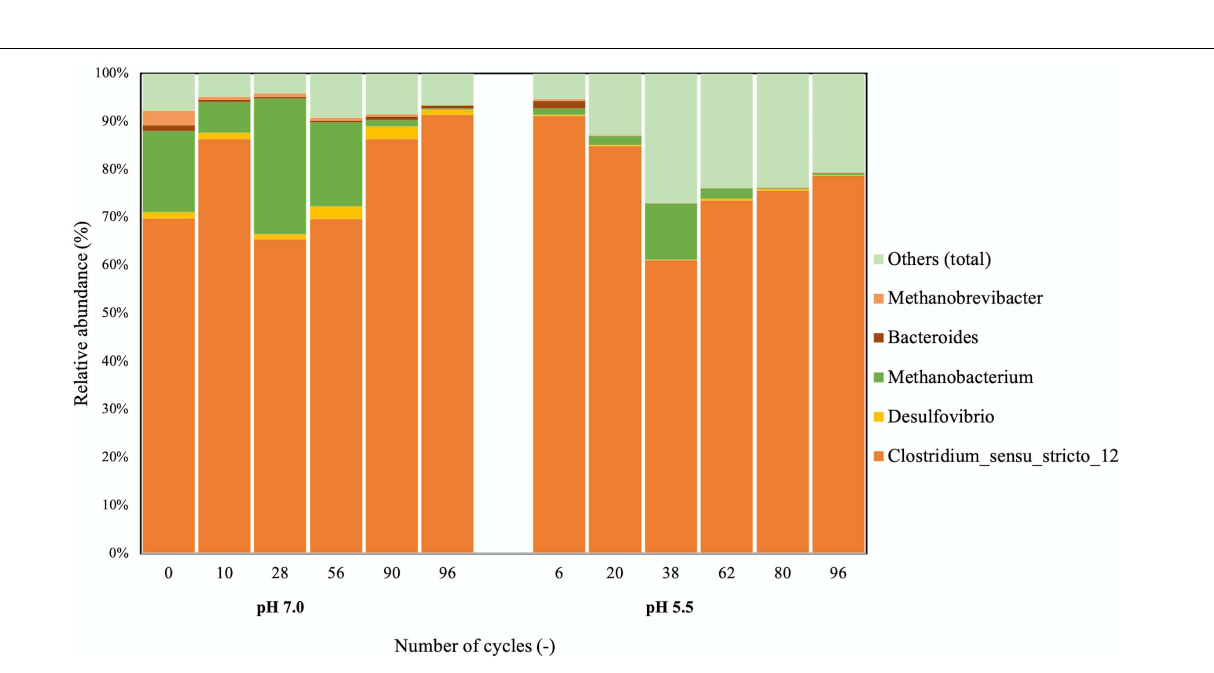
FIGURE 2 | Taxonomic distribution of the microbial communities at pH 7.0 and 5.5. 16S rRNA amplicon sequencing was used to assess the community composition. All samples had a similar number of total reads. OTUs constituting less than 3% of the community were grouped under “Others.” On the x-axis, the number of cycles after which the sample was taken from the bioreactor is displayed for each